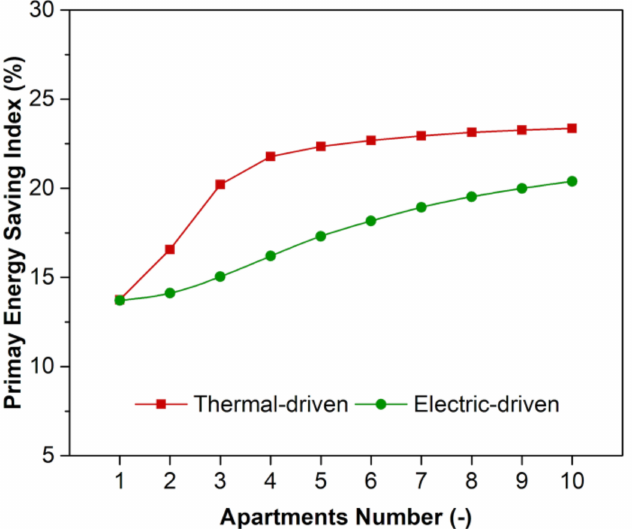
Figure 9. PES index as a function of the number of apartment under the thermal- and electric driven strategies.